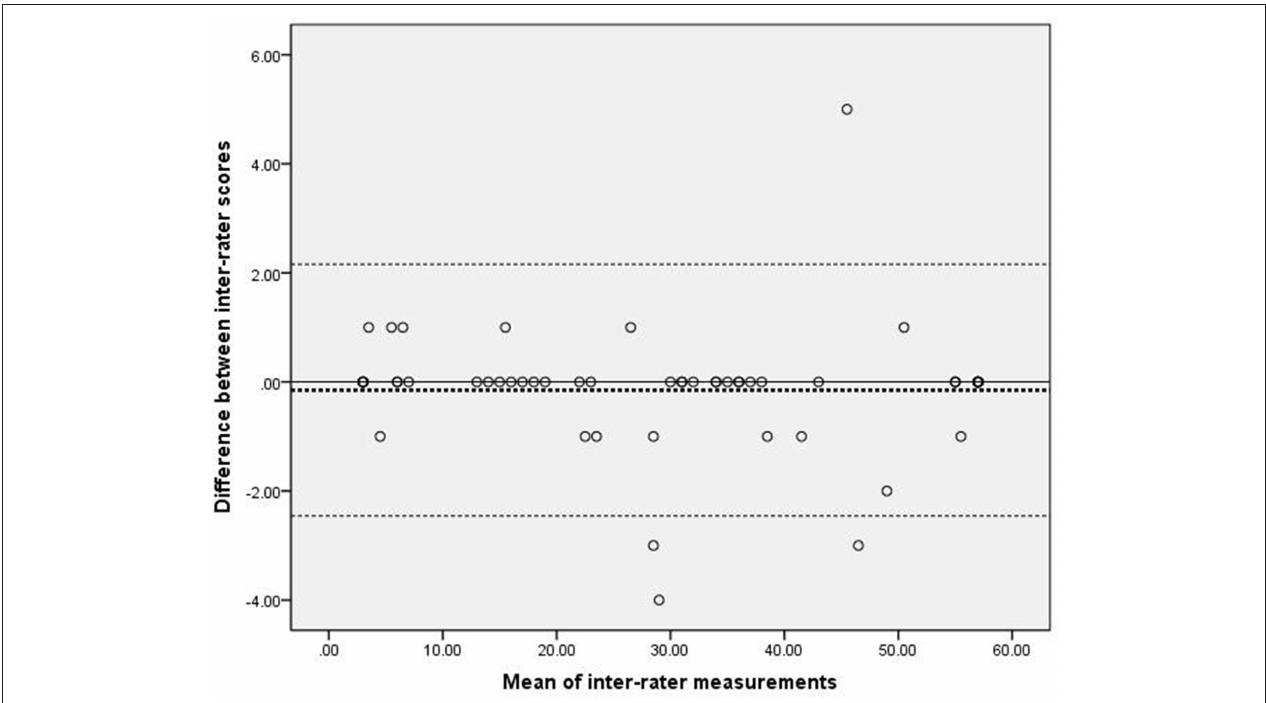
FIGURE 1 | Scatter-plots of the differences between two raters. The dashed bold line represented the mean difference score. The dashed lines represented the limits of agreement (mean ± 1.96 × the standard deviation of the different score).